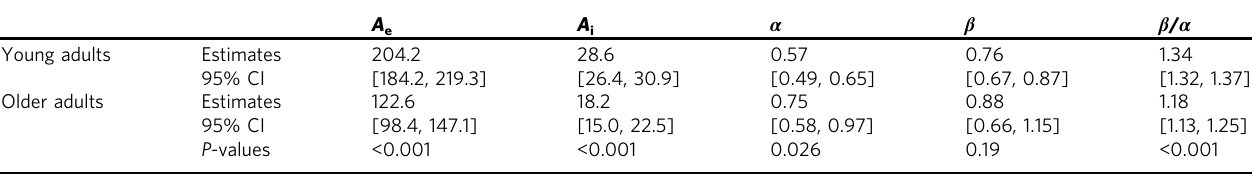
Table 1 Model parameters, comparing young and older adults